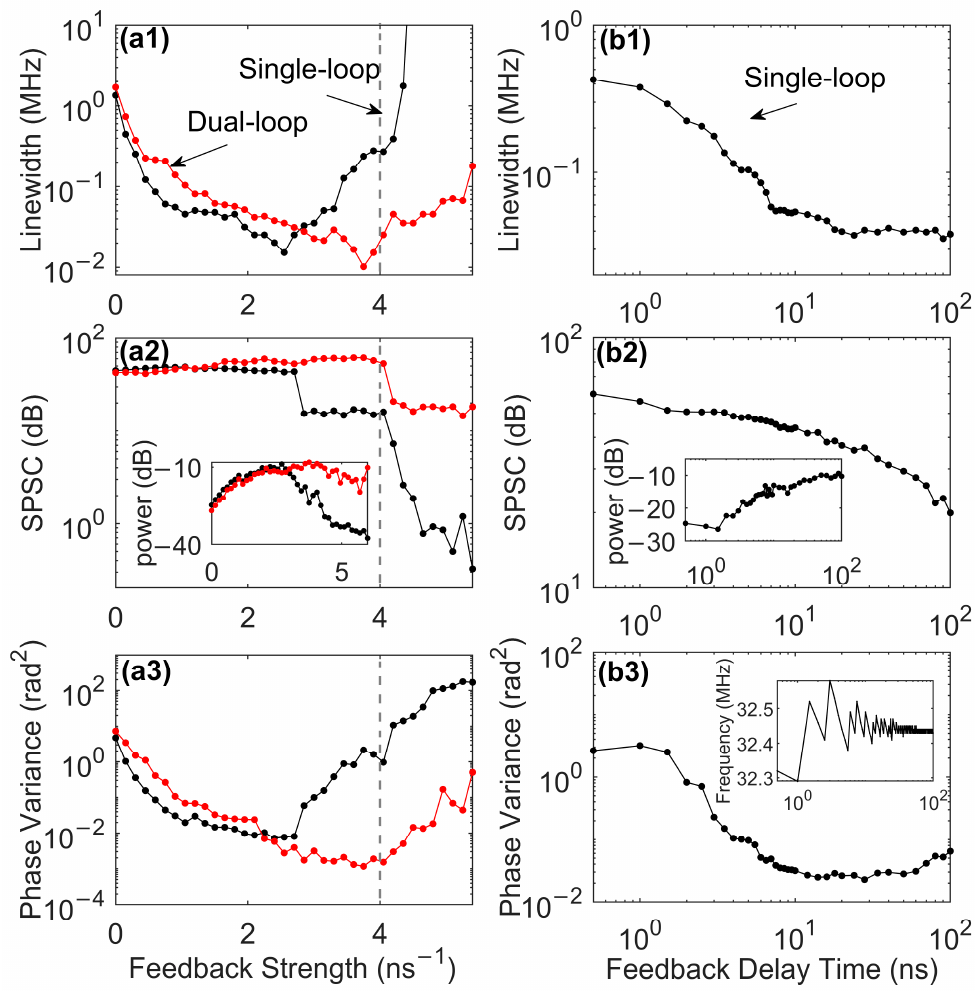
Figure 8. ( a1 , b1 ) Microwave linewidth, ( a2 , b2 ) the SPSC, and ( a3 , b3 ) phase noise variance as a function of the total feedback strength in the left column and feedback delay time in the right column. The feedback strength is set to k f = 3 ns − 1 when the delay time varies. The other parameters are the same as those in Figure 7.